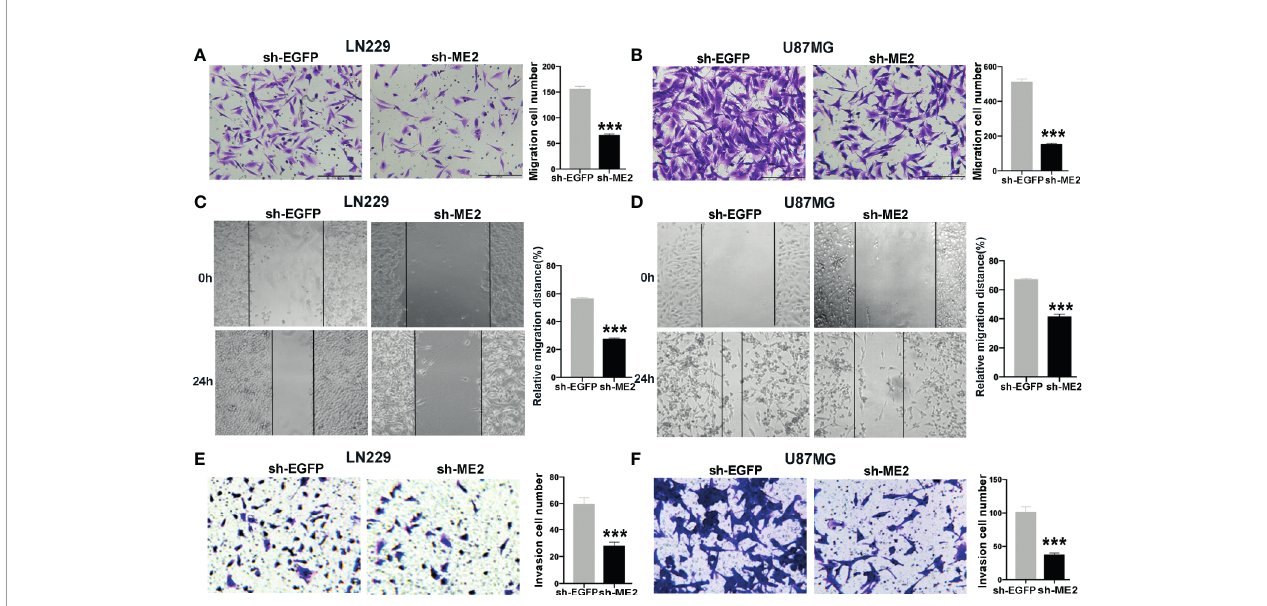
FIGURE 6 | Knockdown of ME2 inhibits migration and invasion of GBM cells. (A) Representative images of the migration of LN229 cells transfected with vector or Flag-ME2 plasmids (***P < 0.0001). (B) Numbers of migrated cells after Flag-ME2 transfection in U87MG cells (***P < 0.0001). (C, D) Representative images of the migration distances of LN229 and U87MG cells transfected with sh-EGFP or sh-ME2 plasmids (***P < 0.0001). (E, F) Invasion ability of LN229 and U87MG cells transfected with sh-EGFP or sh-ME2 plasmids determined by transwell invasion assay (***P <